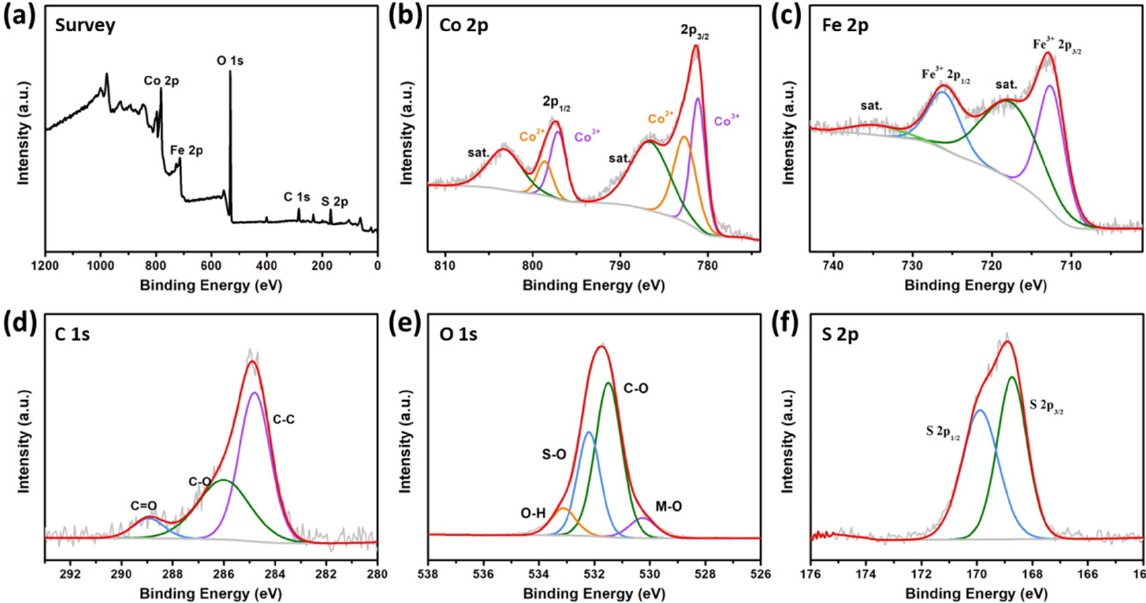
Figure 4. ( a ) XPS survey spectrum and ( b – f ) high-resolution XPS spectra of the Co 2p, Fe 2p, C 1s, O 1s, and S 2p regions of the CoFe LDH sample.